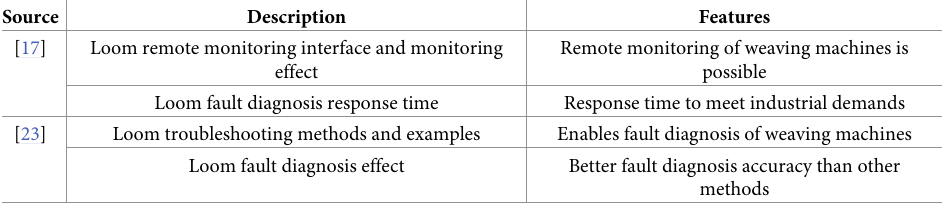
Table 1. Datasets from existing studies for loom fault diagnosis